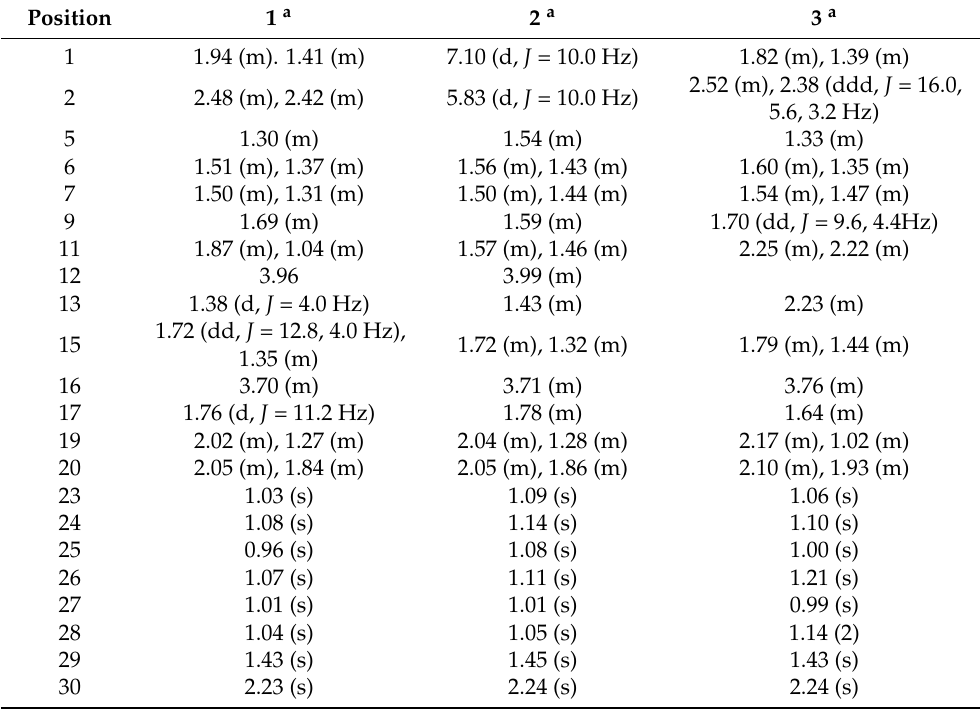
Table 1. 1 H-NMR data for Compounds 1 – 3 ( δ in ppm, J in Hz).